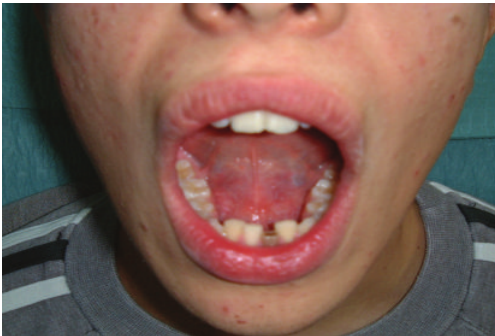
Figure 7: The augmentation in the floor of the mouth due to the intraoral projection of the